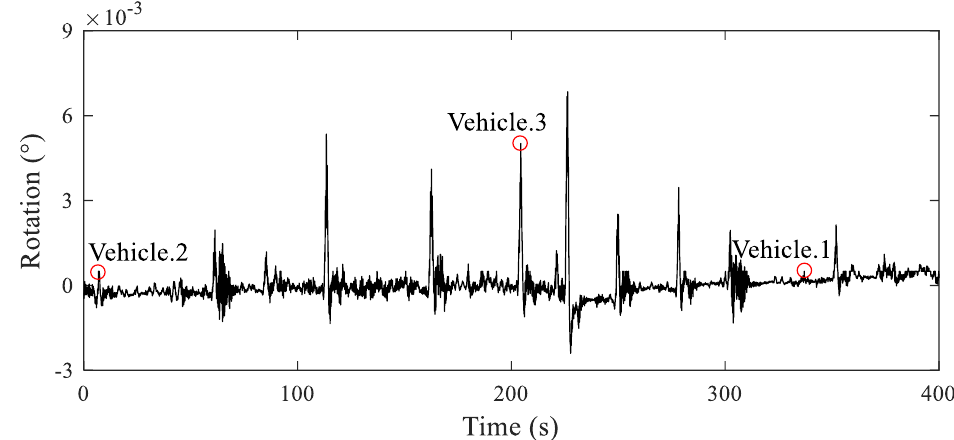
Figure 14. Time-history of typical beam-end rotation response. The time-history data in Figure 14 were divided into segments to isolate each rotation response when only a single vehicle crossed the span. Three typical data for different sizes of vehicles, together with the corresponding photos captured by the UAV, are shown in Figure 15. Figure 15a–c show the different sizes vehicles in each section, and Figure 15d–f show the corresponding beam-end rotation response curves. It is evident that the time required by each vehicle to pass the monitored span was approximately 2 s, indicating that the three vehicles traveled across the bridge at a high speed of approximately 110 km/h (speed limit of the bridge is 120 km/h). The changes in the amplitude of the rotation angle caused by vehicle 1, vehicle 2, and vehicle 3 were 6.2 × 10 − 4 , 3.2 × 10 − 4 , and 46.8 × 10 − 4 ( ◦ ), respectively. The beam-end rotation and corresponding vehicle sizes and weight are listed in Table 3.